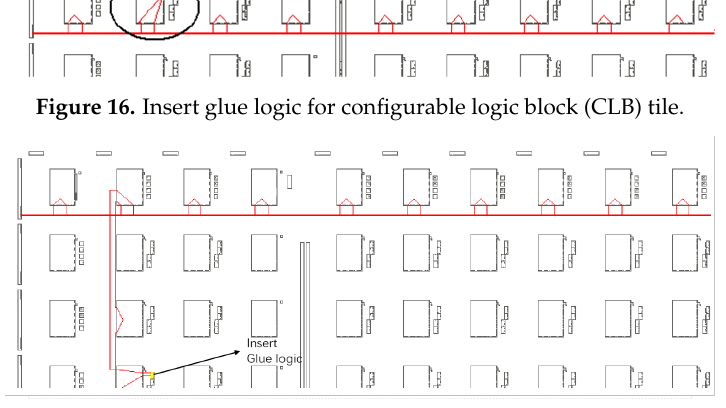
Figure 17. Insert glue logic for IOB tile. Table 1. PIPs in the horizontal and vertical directions in one XC4VLX60